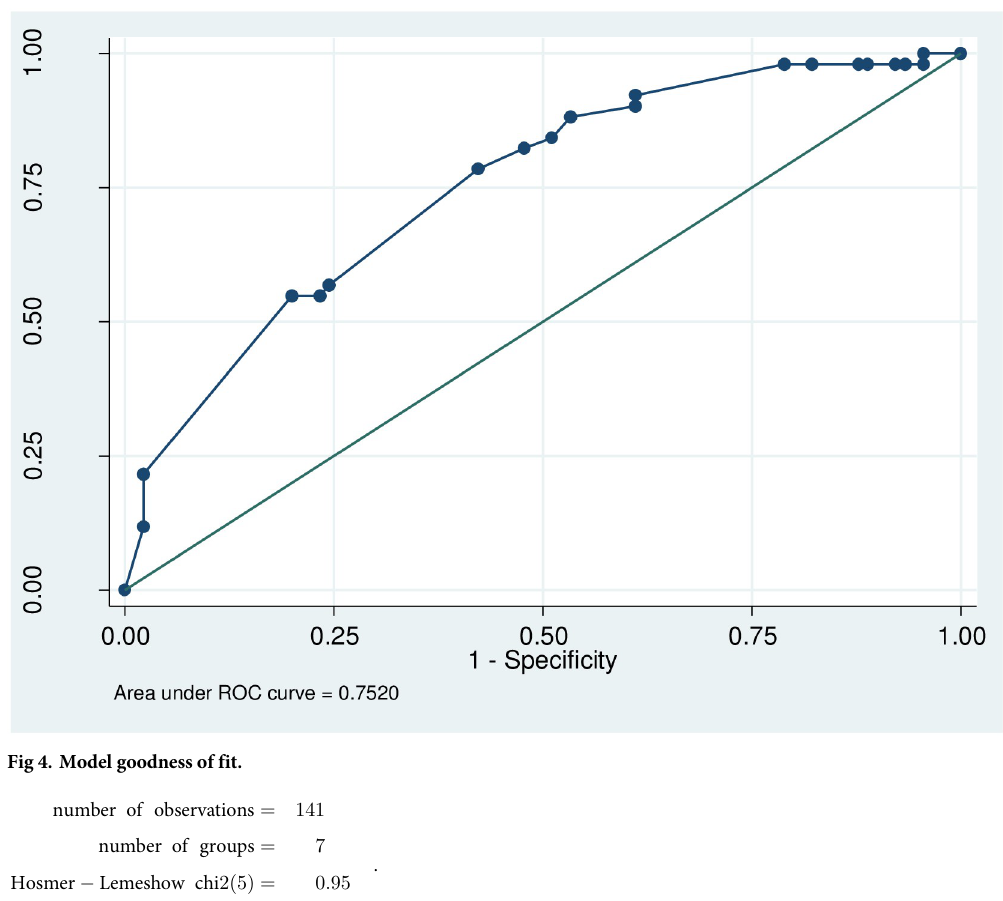
Fig 4. Model goodness of fit. number of observations ¼ 141 number of groups ¼ 7